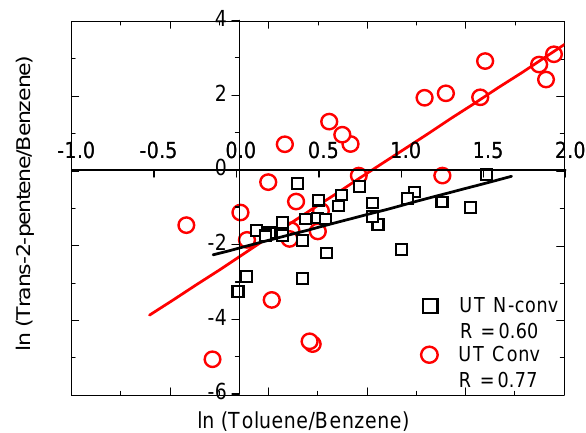
Fig. 8. Natural logarithms of trans-2-pentene to benzene vs. toluene to benzene ratios for F-F20 observations in the UT. Concentrations ratios are shown in black markers in non-convective conditions and in red markers during convective conditions. Lines show linear fits for each data set.